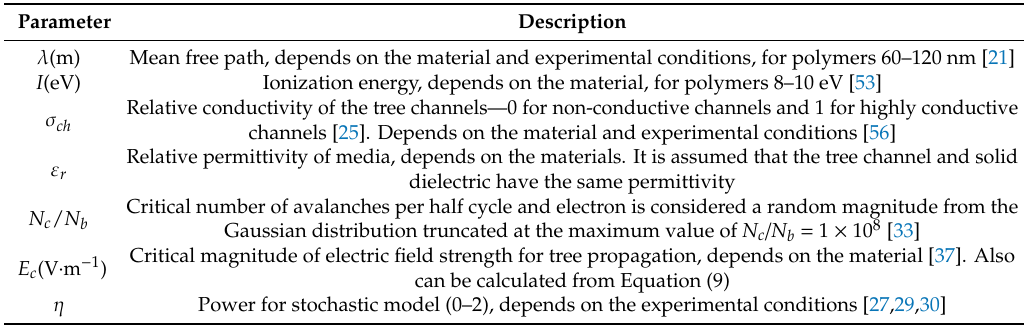
Table 1. Input parameters for the proposed improved model.